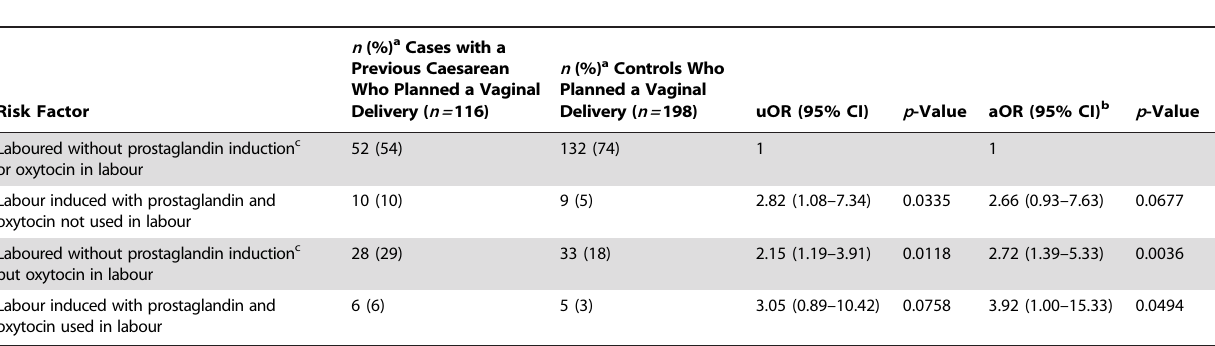
Table 5. Risk factors for uterine rupture in women with prior delivery by caesarean section who planned to have a vaginal delivery in current pregnancy.